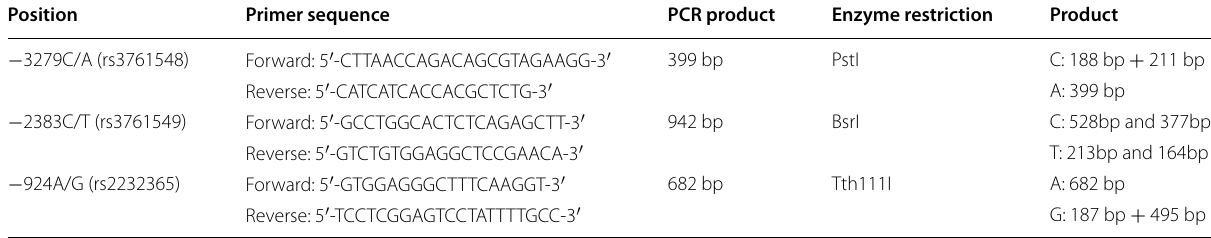
Table 1 Primers sequence, restriction enzymes, and fragments size of selected SNPs Position Primer sequence